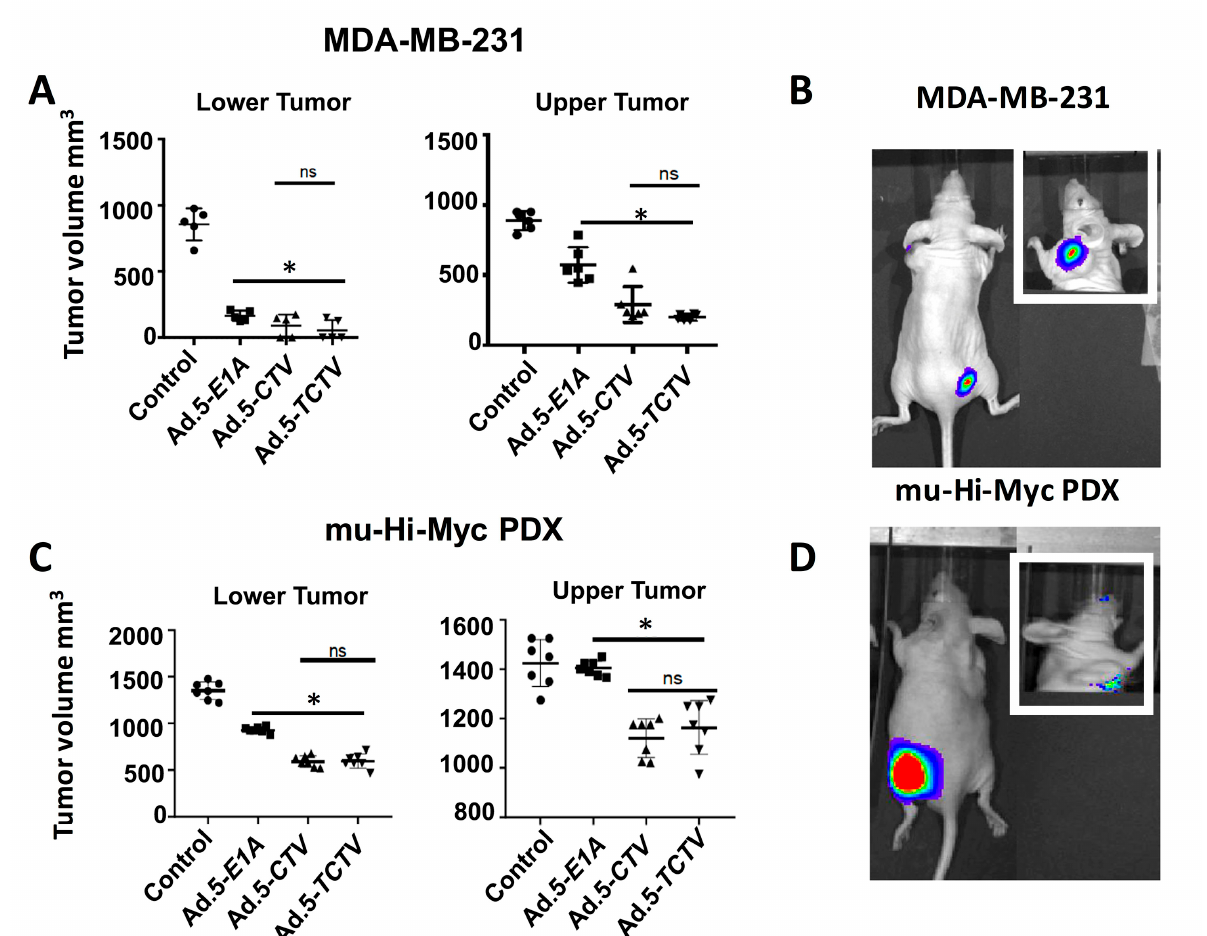
Figure 5. Ad.5- TCTV inhibits tumor growth to a comparable level of Ad.5- CTV and additionally permits non-invasive imaging of tumor growth in vivo . MDA-MB-231 (breast) and mu-Hi-Myc PDX (prostate) cancer cells were implanted subcutaneously in the lower and upper flanks of nude mice and lower tumors were treated with eight intratumoral injections of solvent (mock treatment-Control), Ad.5- E1A , Ad.5- CTV, or Ad.5- TCTV . A total of five animals were studied in each group. Once the tumors in untreated mice reached maximum IACUC acceptable limits, mice were euthanized and tumors were collected, fixed in formalin, and embedded in paraffin. ( A and C ) Tumor volumes from the lower (injected tumors) and upper flanks (un-injected tumors) were measured and the results are presented in a graphical manner. The line represents average of all tumor volumes of the group. * p < 0.05 vs. control, ns: no significant difference between Ad.5- CTV or Ad.5- TCTV group. ( B and D ) Ad.5- TCTV injected tumors were visualized using BLI (IVIS imager). Inset, BLI image of un-injected tumors following injection of lower flank tumor with Ad.5- TCTV.